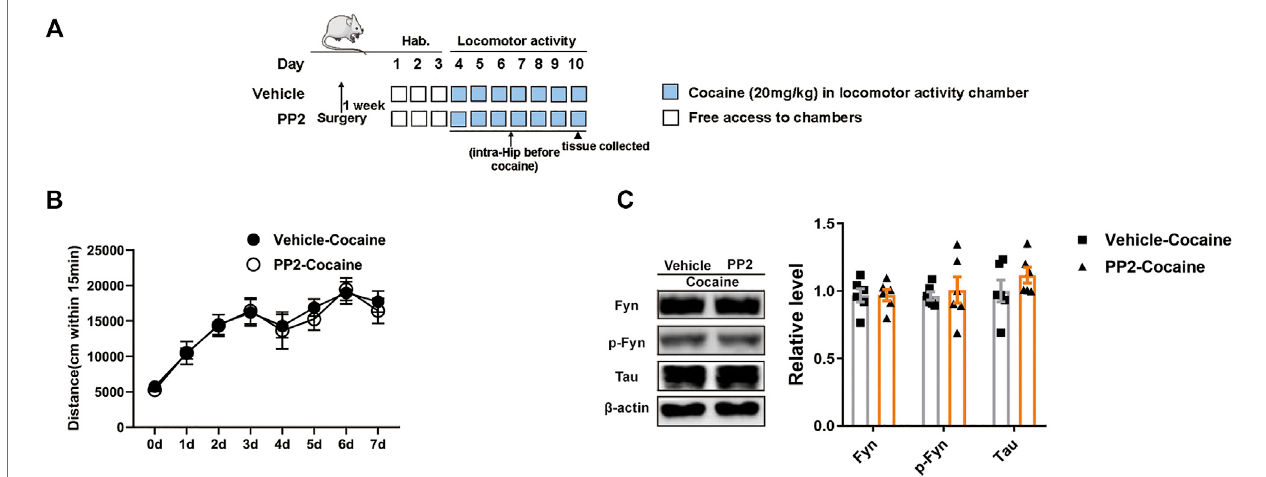
FIGURE 3 | PP2 infusion into the hippocampus failed to weaken cocaine locomotor activity. (A) Timeline of cocaine locomotor-activity. (B) Total distance traveled 15 min after daily cocaine administration ( n = 10 per group). (C) Western blot of Fyn, phosphorylated Fyn, and Tau in the hippocampus after cocaine hyperlocomotion paradigm ( n = 6 per group). Data are the means ±